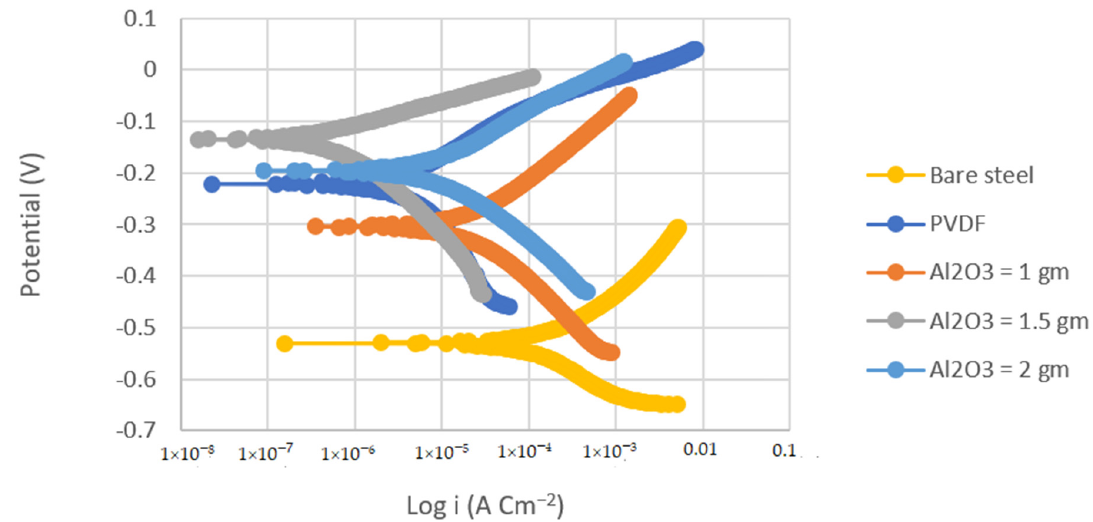
Figure 4. Tafel plots of bare steel, PVDF-coated steel, and coated steel with coatings of different Al 2 O 3 contents (1, 1.5, and 2 g) in 3.5% NaCl solution (Scan rate = 2 mVs − 1 ). 1×10 − 8